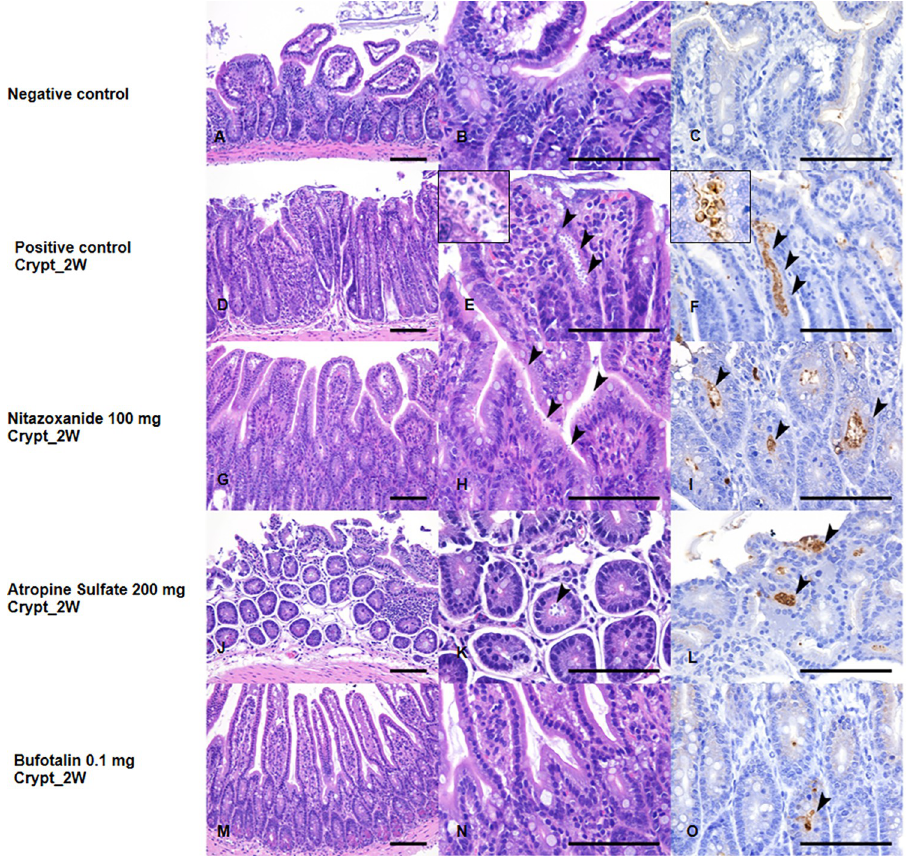
Fig 5. Histological observation with immunohistochemistry detection of C . parvum infection in ileum tissues. Histological sections of small intestine (ileum) of different animal groups (treated with nitazoxanide, atropine-sulfate, bufotalin, and control groups). Except for the negative control group, all mice were orally inoculated with Cryptosporidium parvum oocysts (1 × 10 5 ), then treated with each compound. The left column is the lower magnification for hematoxylin and eosin (HE), the middle column is the higher magnification for HE, and the right column is immunohistochemistry for C . parvum . The severity of C . parvum infection was scored from–to 3+. (A-C) Ileal sections of uninfected mouse (negative control) (Score: -). (D-F) Ileal sections of non-treated mouse (positive control) showing inflammatory cell infiltration of the mucosal layer. Numerous C . parvum oocysts are attached to the intestinal villi (Score: 3+) (arrowheads: C . parvum oocysts). Ileal sections of nitazoxanide-treated groups (G-I), Nitazoxanide-treated group (Score: 2+) showing a number of oocysts. (J-L) Atropine sulfate-treated group showing less reduction of oocysts (Score: 2+). (M-O) Bufotalin-treated group showing markedly reduced number of oocysts (Score: 1+). Bar = 100 μ